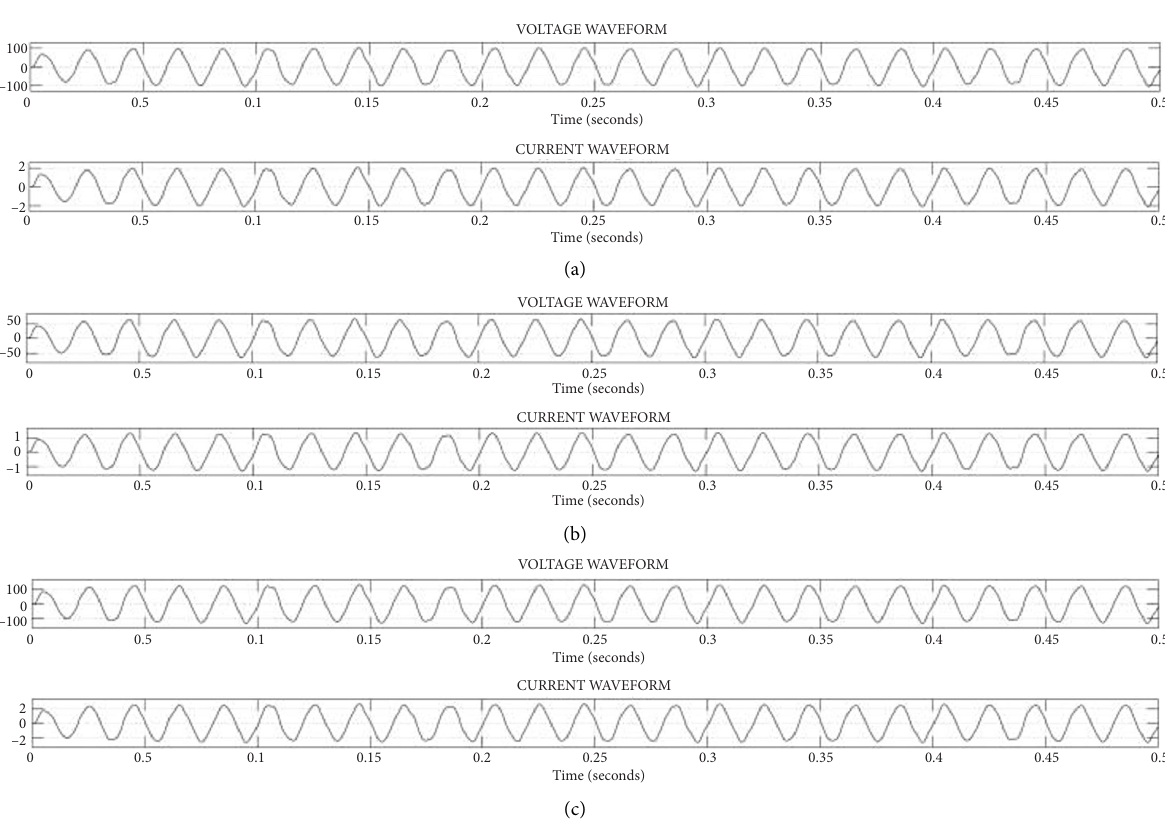
Figure 17: Output waveforms [18]. (a) Output waveforms for 50 V input. (b) Output waveforms for 75 V input. (c) Output waveforms for 100V input.